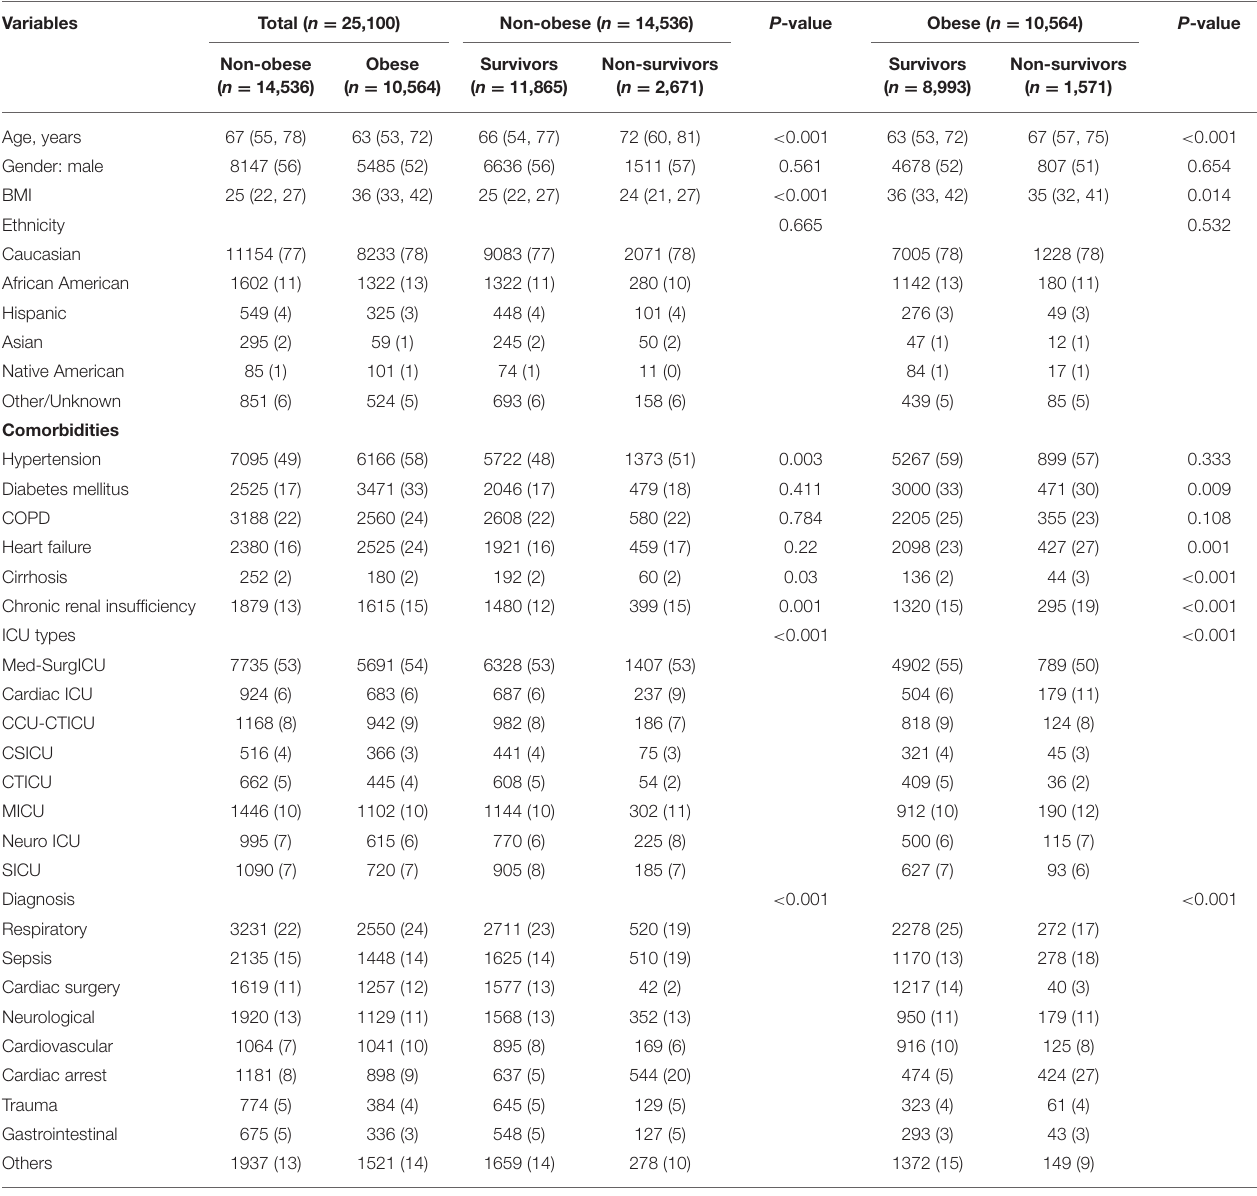
TABLE 1 | Baseline characteristics of study